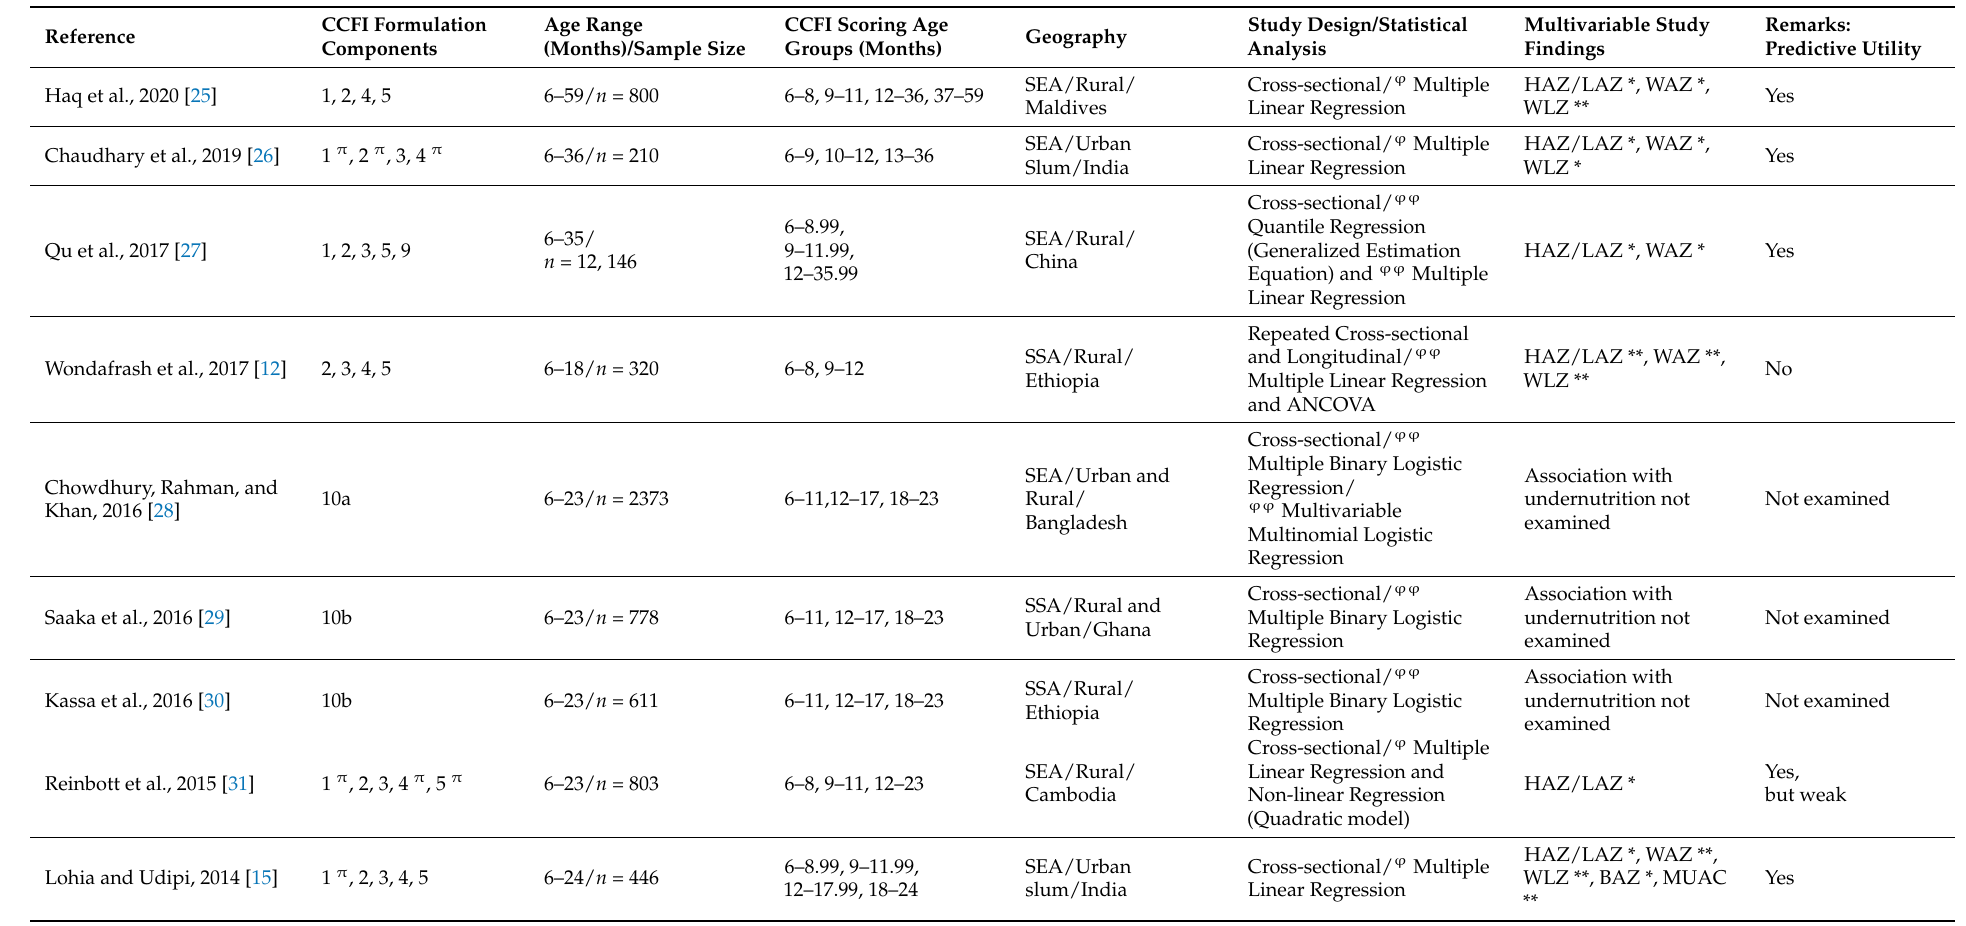
Table 1. Summary of CCFI components used in the construction of some child feeding indices and the study